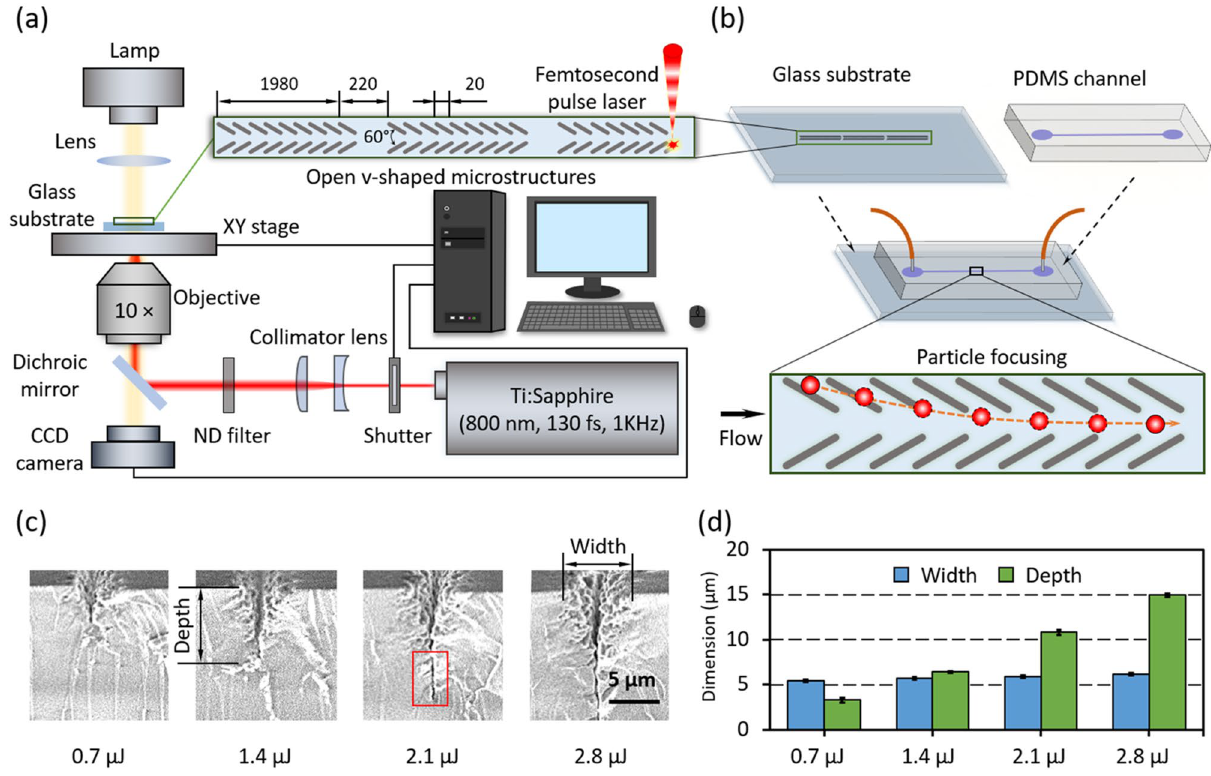
Figure 1. Femtosecond pulse laser engraved glass surficial microstructures for particle focusing in a microchannel. ( a ) Schematic illustration of the laser engraving system. ( b ) Schematic illustration of the microfluidic device for continuous focusing of microparticles. ( c ) SEM images of top and bird’s-eye views of the grooves engraved by four different pulse energies: 0.7, 1.4, 2.1 and 2.8 µJ/pulse. ( d ) Plots of width and depth of grooves against the engraving pulse